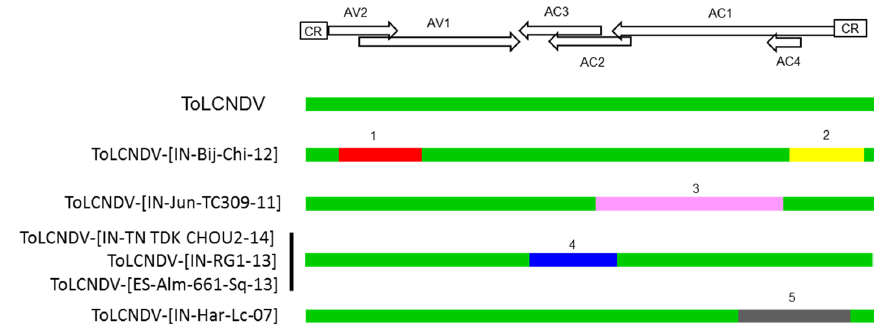
Figure 4. Putative recombination events of the isolates of ToLCNDV. Schematic representation of the putative recombination events present in the DNA-A of isolates of tomato leaf curl New Delhi virus (ToLCNDV) that differ from the reported ones at the strain threshold level detected using the Sequence Demarcation Tool (SDT) analysis (highlighted with asterisks in Figure 3) compared to ToLCNDV standard isolates and deduced based on the results from the recombination detection software program (RDP4; Version 4.0) [31]. Whereas the green color indicates ToLCNDV-derived sequences, all other colors indicate sequences derived from non-ToLCNDV sources, with recombination events numbered according to Table 2.